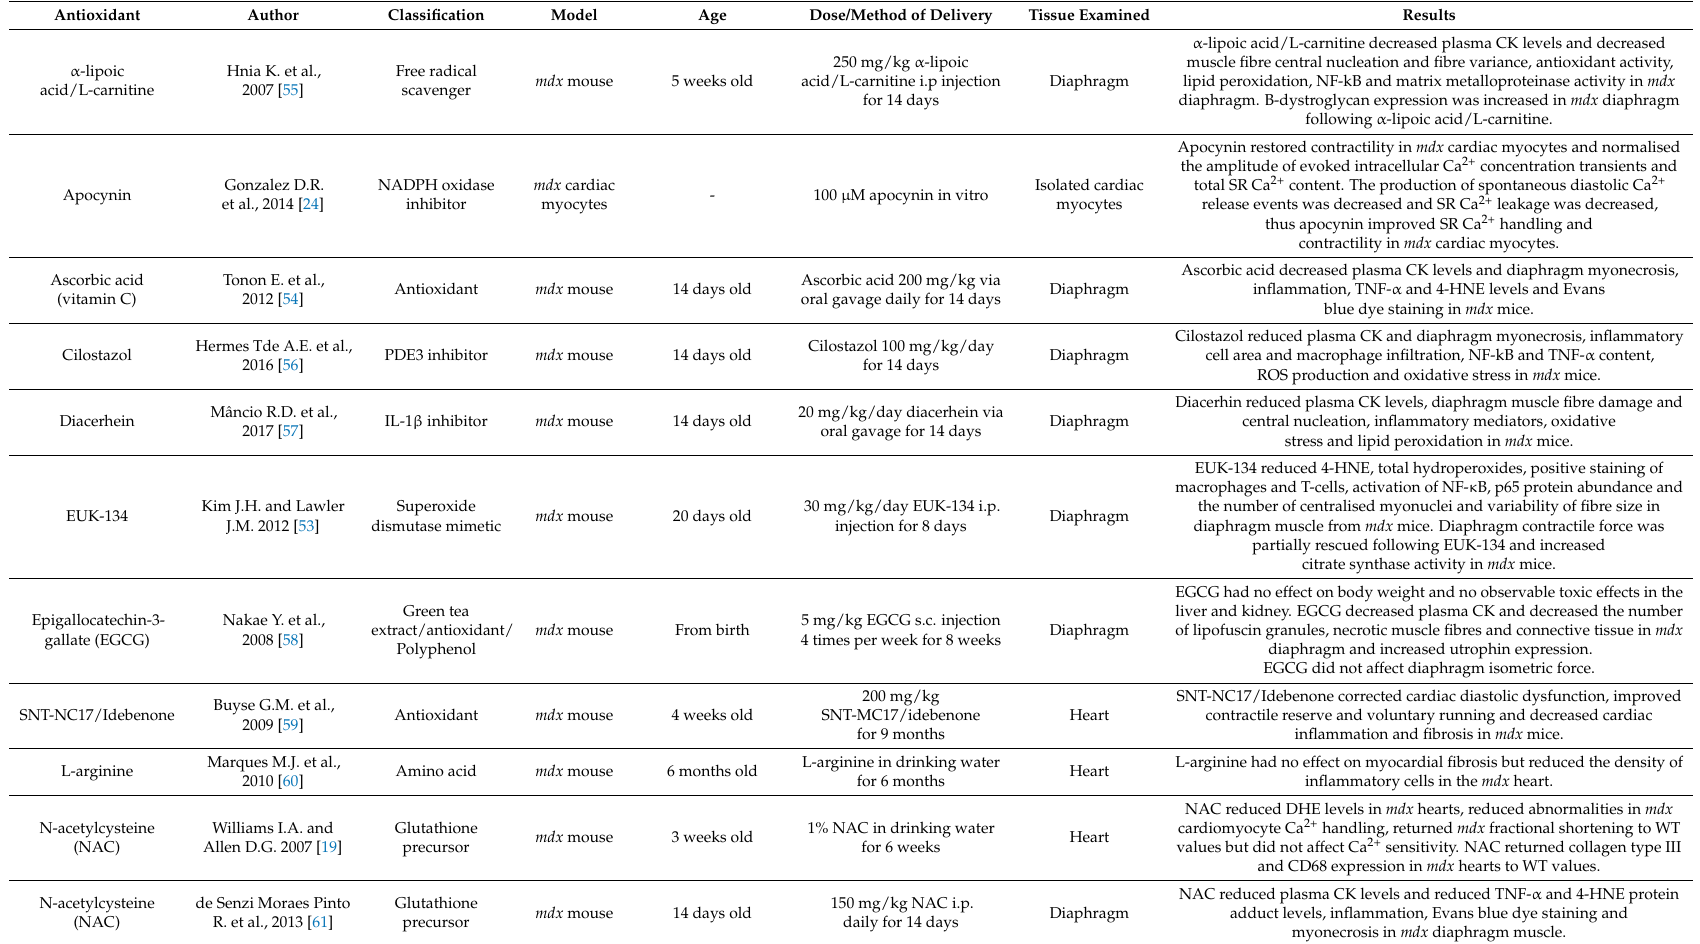
Table 2. Overview of studies assessing antioxidant intervention in mdx